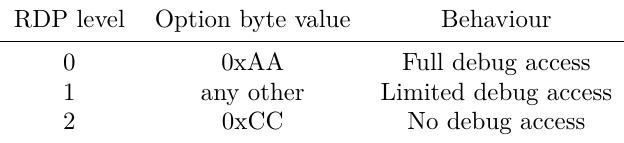
Table 2: Read-out protection (RDP) levels of the STM32L4 microcontroller